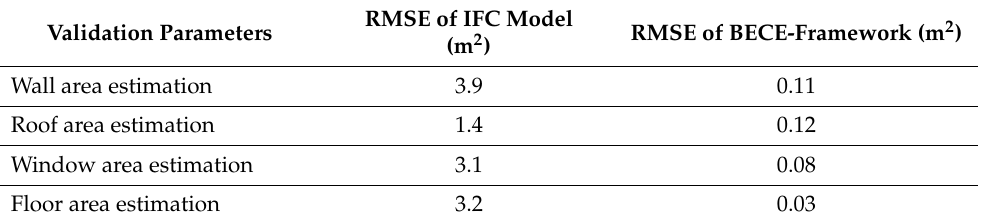
Table 7. The error of geometry information extracted from the IFC model of test case 2 with 130